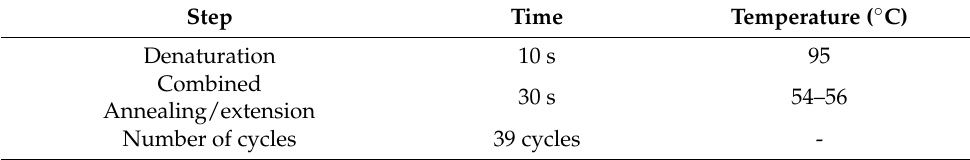
Table 2. qRT-PCR cycle